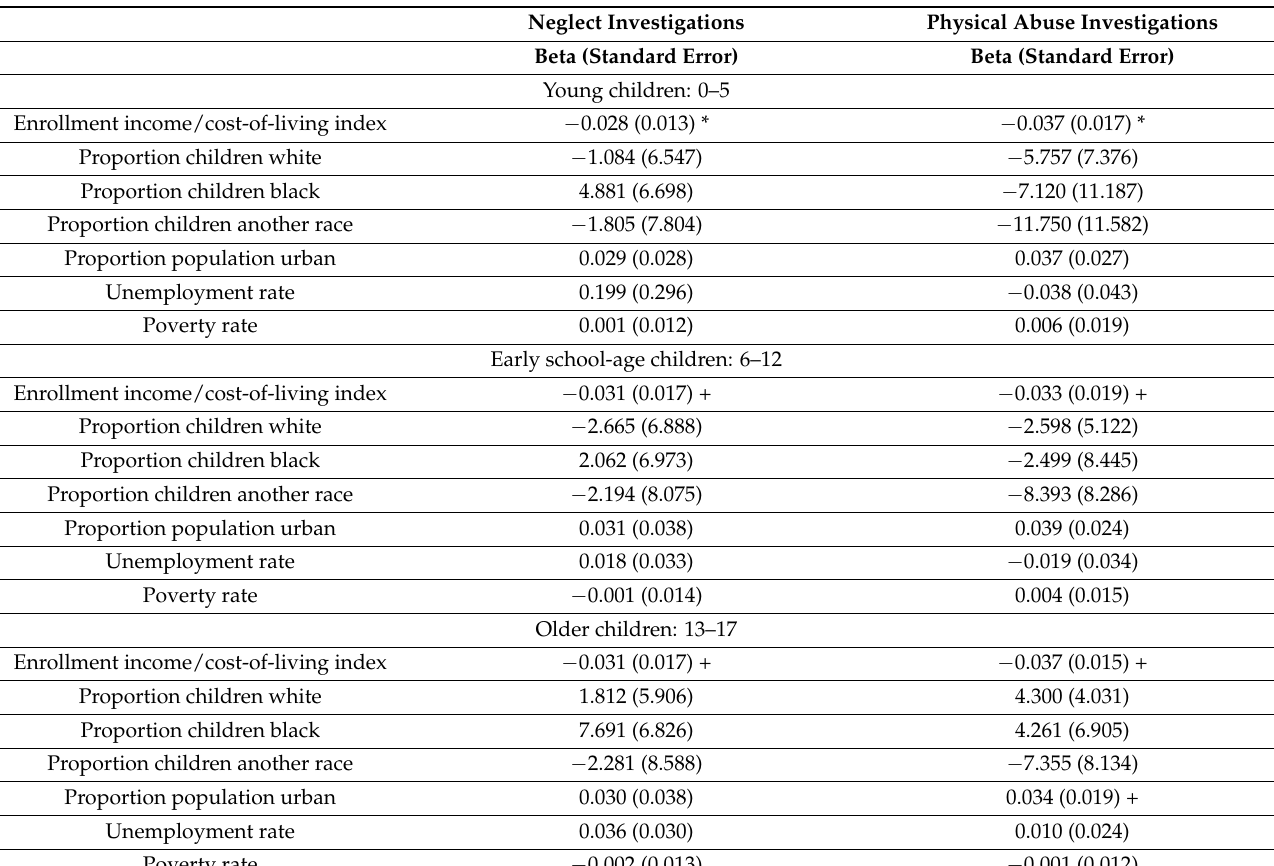
Table 2. OLS Regression Enrollment Income Adjusted for Cost of Living and Child